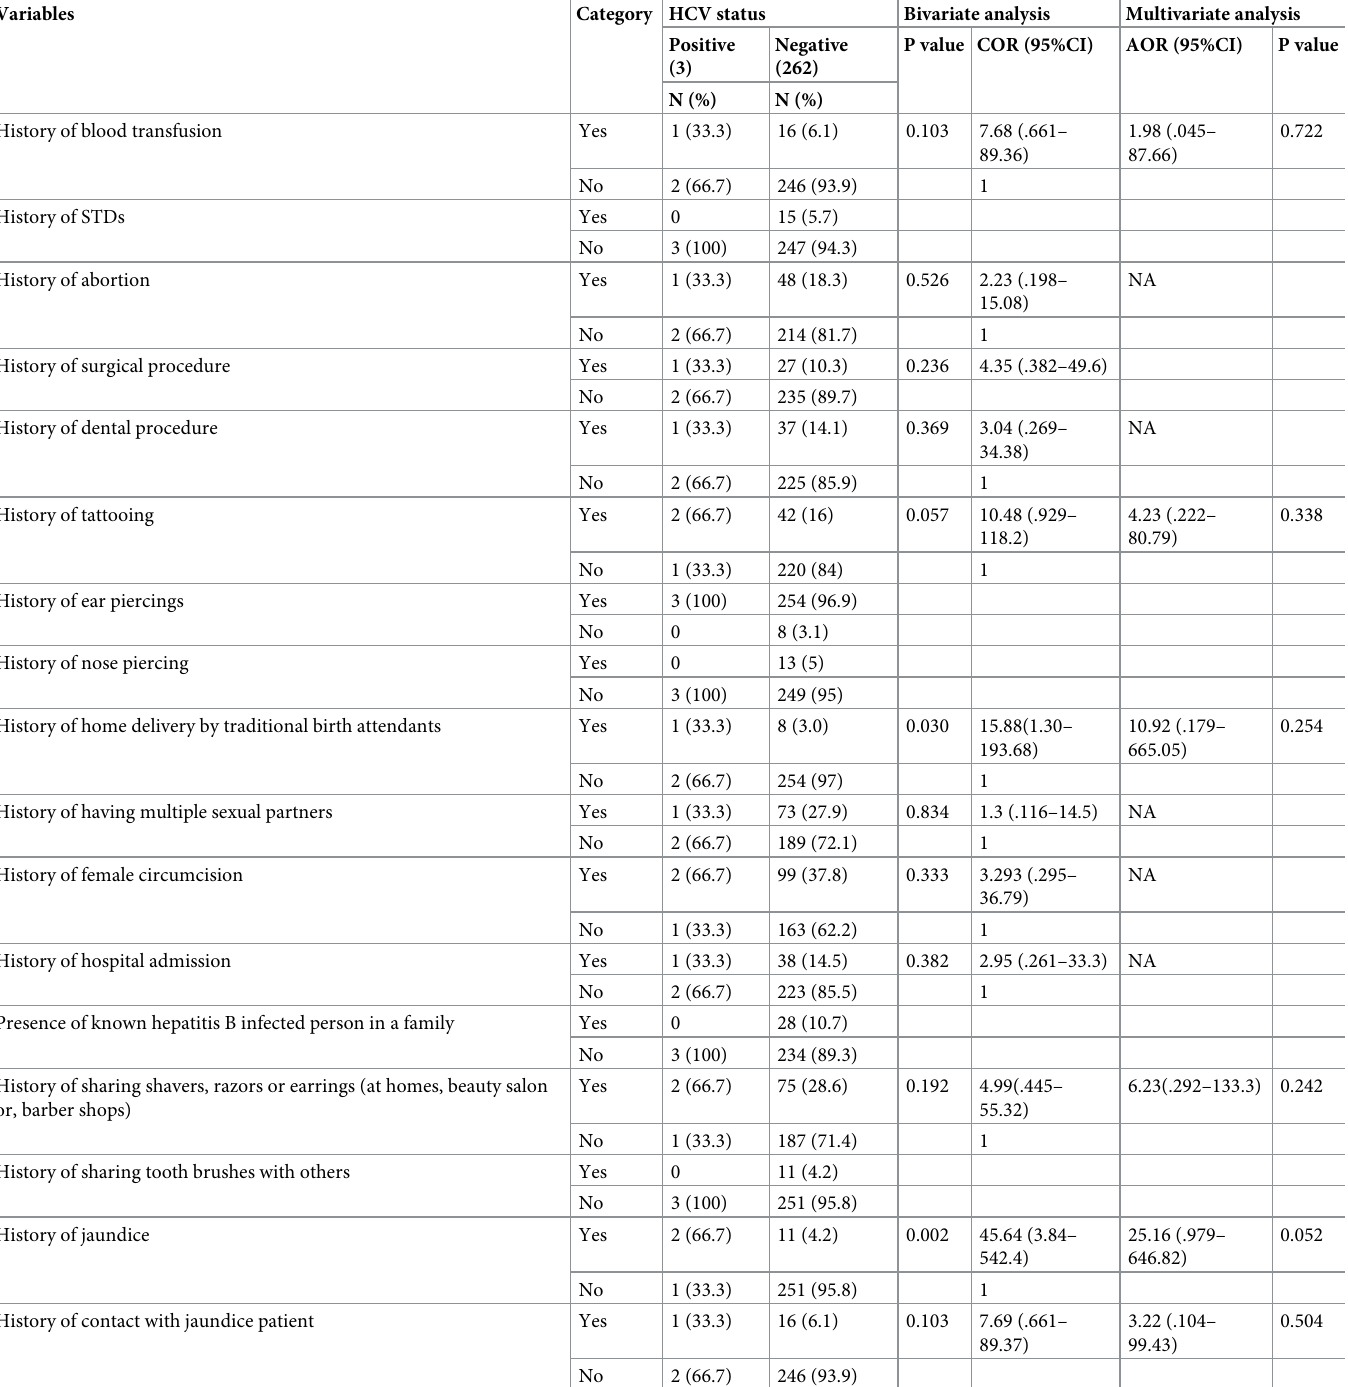
Table 5. Statistical association of predictor variables with HCV co-infection among HBsAg positive delivering mothers in governmental hospitals in Addis Ababa,